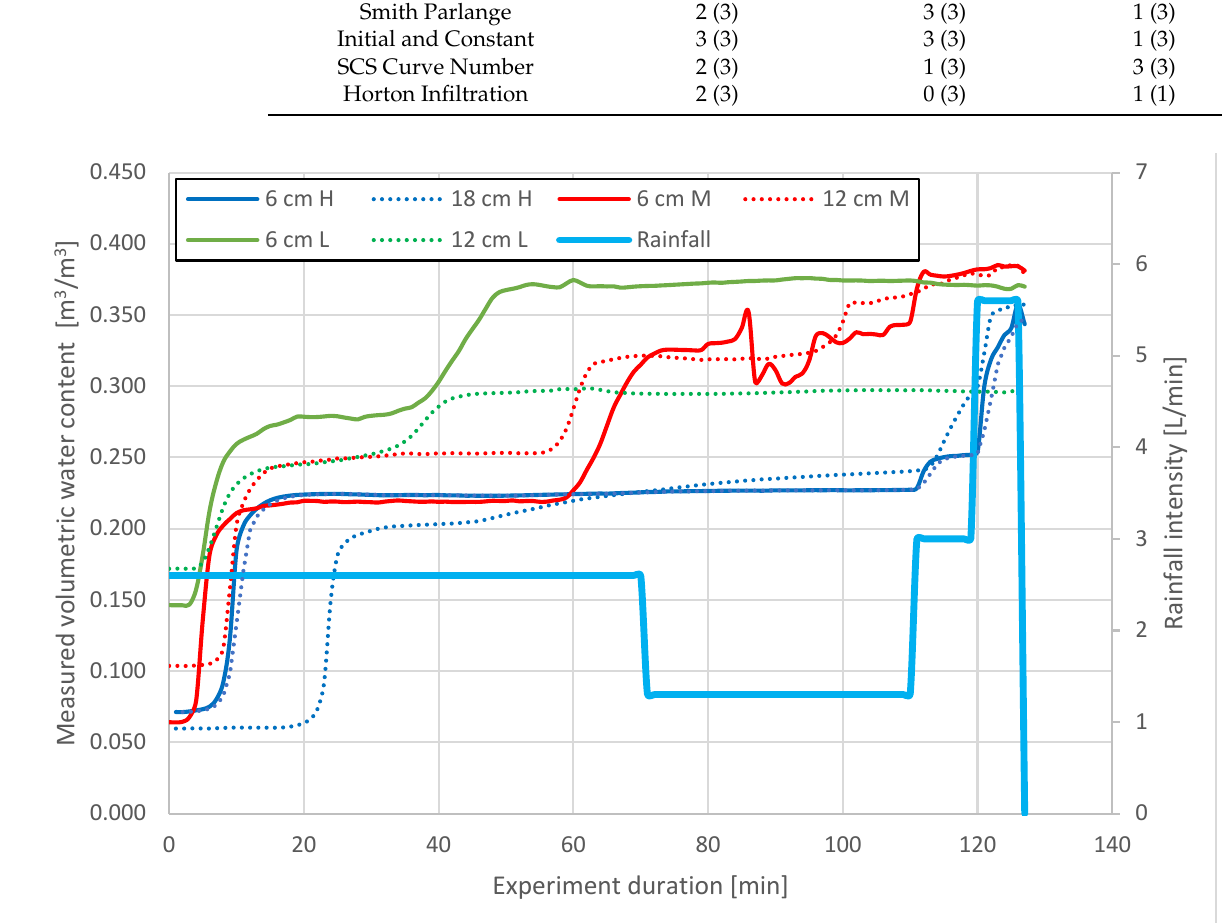
Figure 3. Measured volumetric water content during the experiment with sand (Sand). Measured locations (H, M and L) are shown in Figure 2. Note that quick changes in the volumetric water content can be associated with the development of slope instabilities.